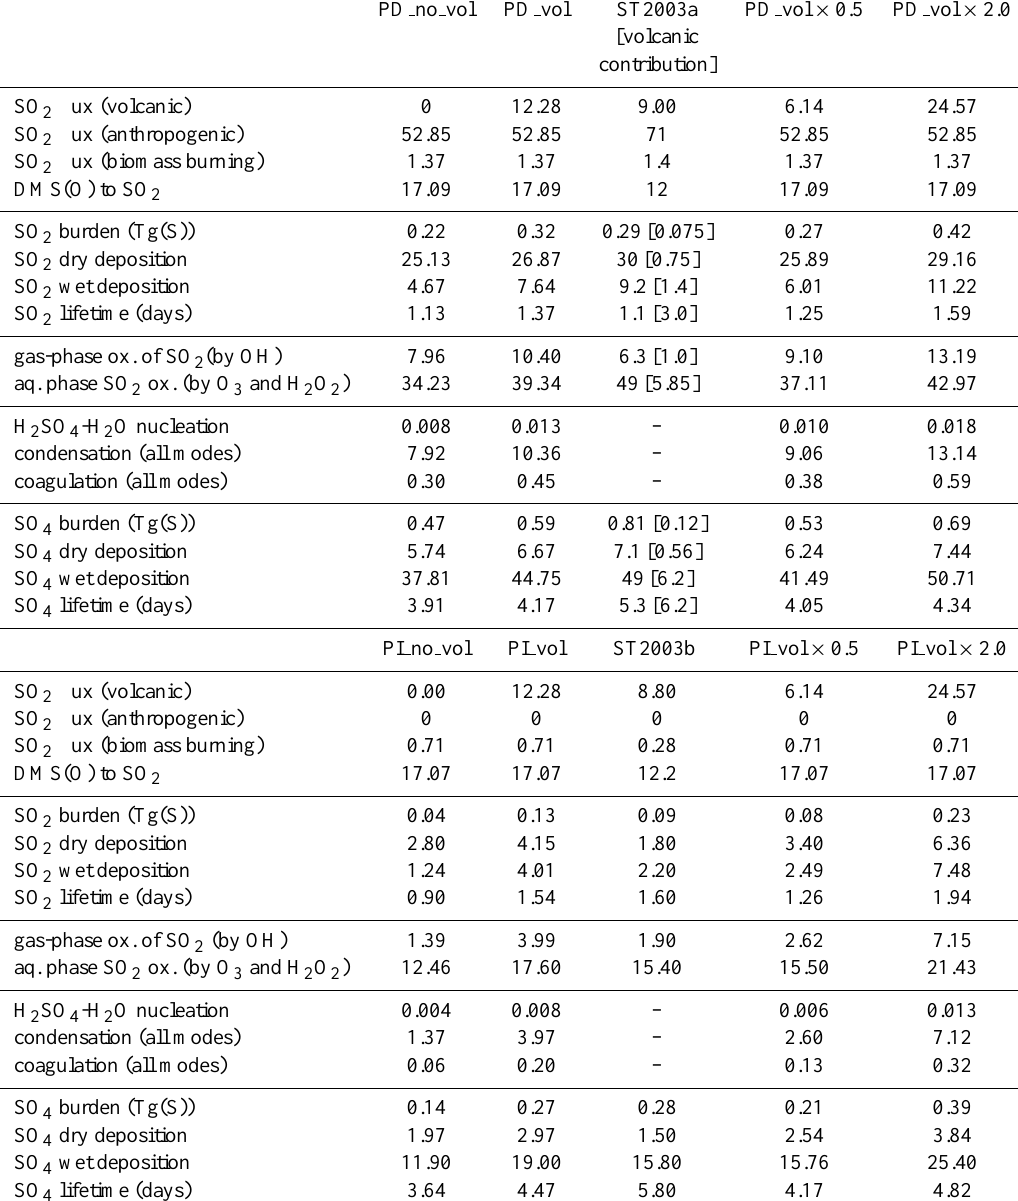
Table 2. Simulated global annual mean sulphur budget showing fluxes (Tg ( S ) a − 1 ), burdens in Tg(S) and lifetimes (days). ST2003a refers to Stevenson et al. (2003a) with values in parentheses denoting their estimate of the volcanic contribution, and ST2003b refers to the 1860 simulation in Stevenson et al. (2003b). Note, for our study the SO 2 fluxes from different sources are given following the partitioning into SO 2 and sub-grid sulphate (see Sect. 2.2 for